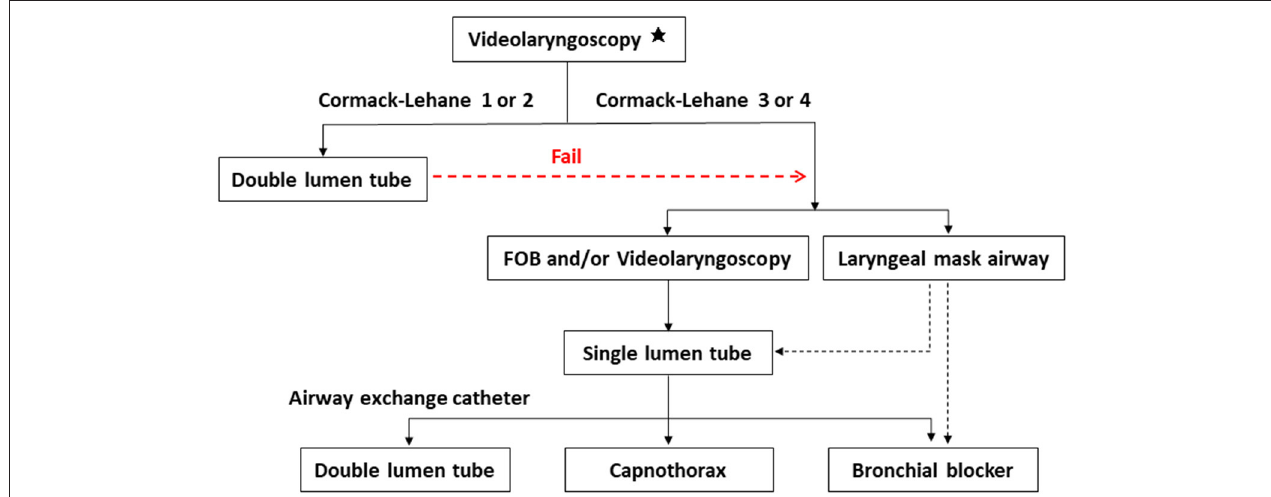
FIGURE 2 | Several strategies to achieve one-lung ventilation in difficult airways using videolaryngoscopes. *Backward, upward and rightward pressure of larynx (BURP) maneuver is used to improve glottic exposure if required. Using videolaryngoscopy, the glottic view is determined according to Cormack-Lehane classification. Grade 1, most of the glottis is visible; grade 2, partial glottis is visible; grade 3, only the epiglottis is visible; grade 4, not even the epiglottis can be seen. If the glottic view is adequate, a double lumen tube is placed with the guide of videolaryngoscope. In case of failure or inadequate glottic view, a single lumen tube is placed with FOB and/or videolaryngoscope, or the patient is secured with a laryngeal mask airway. Then one-lung ventilation is achieved through exchange of a double lumen tube over an airway exchange catheter, inserting a bronchial blocker, or capnothorax. FOB: fibreoptic